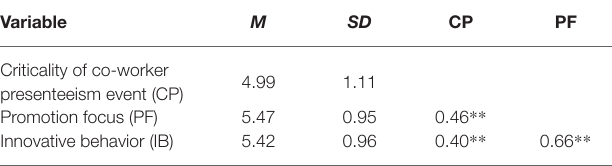
TABLE 2 | Means, standard deviations and correlations for latent